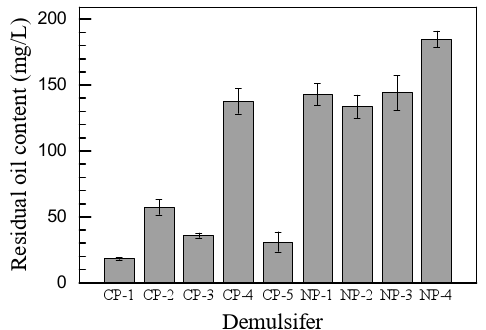
Figure 3. Performance of demulsifiers in treating EOR PW from the Xinjiang Oilfield. Oil content in PW, 358.5 mg/L. Dose of demulsifiers, 500 mg/L. Temperature, 40 °C. Table 1. Characteristics of produced water from HPAM/petroleum sulfonate flooding in the Xinjiang Oilfield.